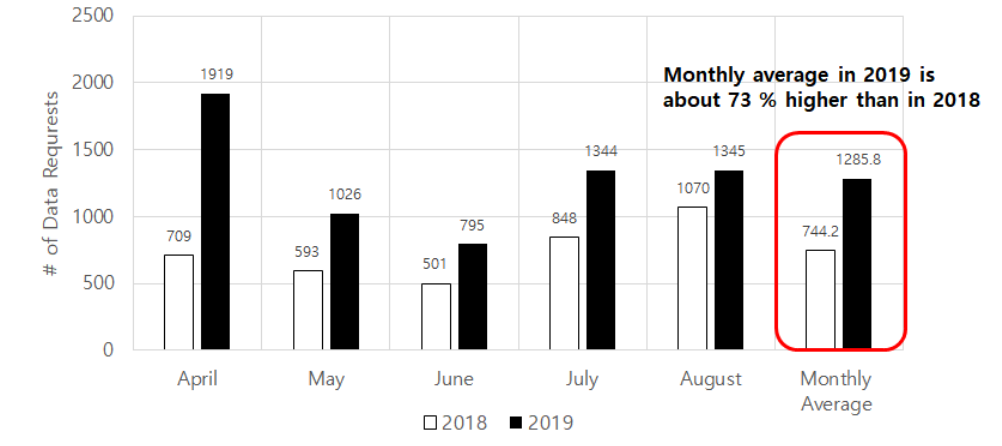
Figure 9. Comparison of Raw Data Requests in 2018 and